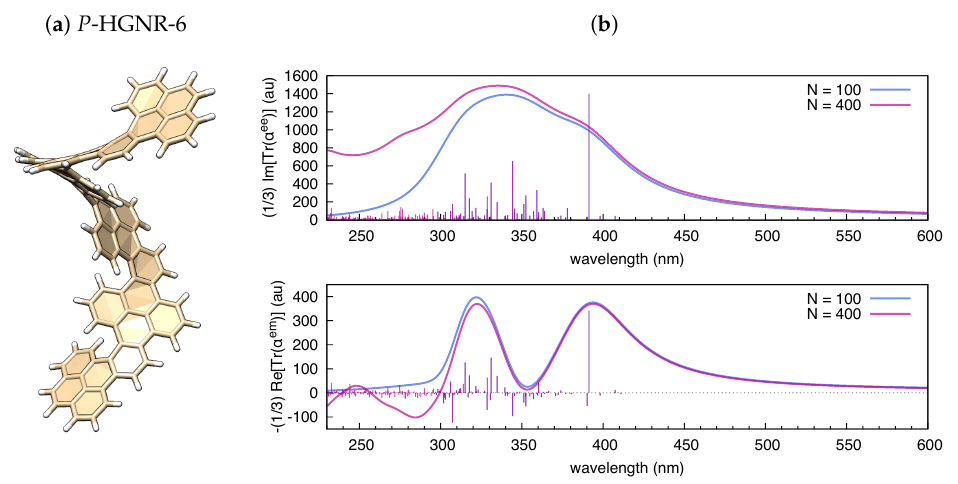
( a ) Graphical representation of the equilibrium structure of P -HGNR-6 (data from B3LYP/6-31g(d,p) DFT calculation); and ( b ) electronic absorption and circular dichroism of P -HGNR-6 simulated by polar ( Γ = 0.5 eV) based on results from TDDFT calculations (B3LYP/6-31G(d,p); N = 100 and N = 400 states).